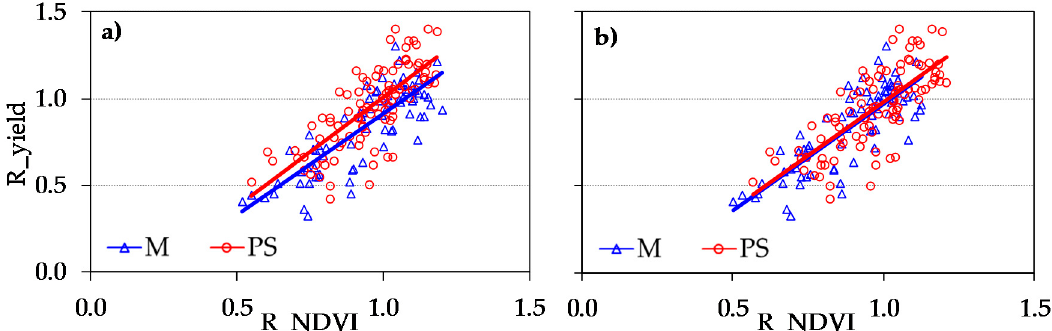
Figure 2. Relationship between R_yield and R_NDVI (relativized to maximum values of each year) in the PS and M treatments ( a ) and relationship between R_yield (relativized to maximum value of each year) and R_NDVI (relativized to maximum value of each year and within each year individually for the PS and M treatments) for PS and M treatments ( b ); 2012 and 2013 pooled data.